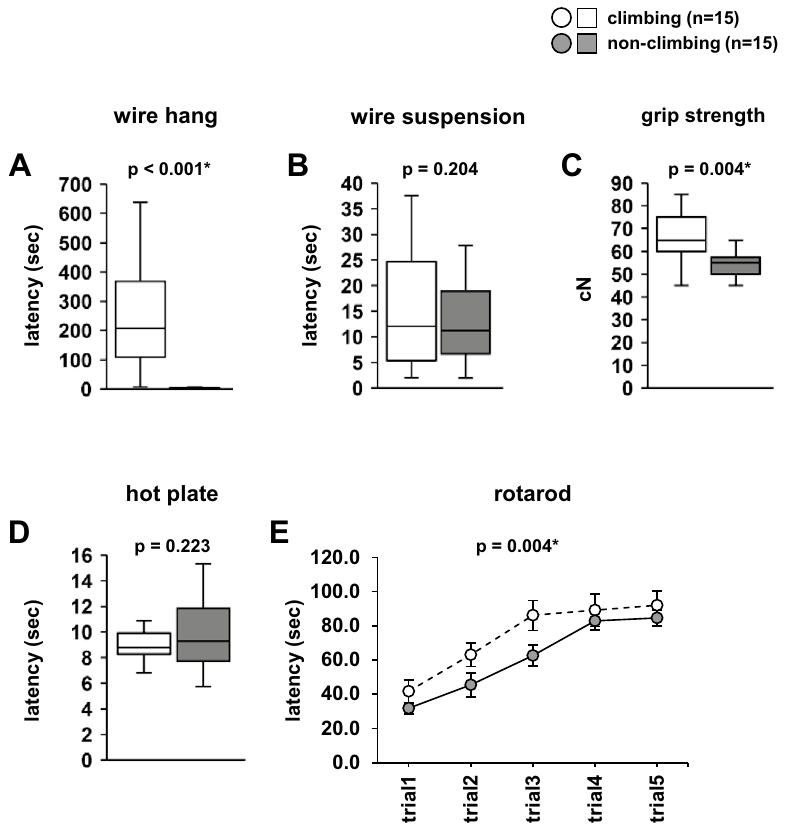
Figure 4. The effect of grid-climbing prevention on physical characteristics. The latency to fall in the wire hang test ( A ), latency to fall in the wire suspension test ( B ), grip strength ( C ), latency to the first paw response in the hot plate test ( D ), and latency to fall in the rotarod test ( E ). Data are presented as box plots ( A – D ) or mean ± standard error ( E ). Statistical significance is represented by asterisks: * p < 0.05, + p < 0.1. P -values were calculated using the one-way analysis of variance (ANOVA) ( A – D ) or two-way repeated-measures ANOVA ( E ). ( A – E ) climbing: n = 15; non-climbing: n =